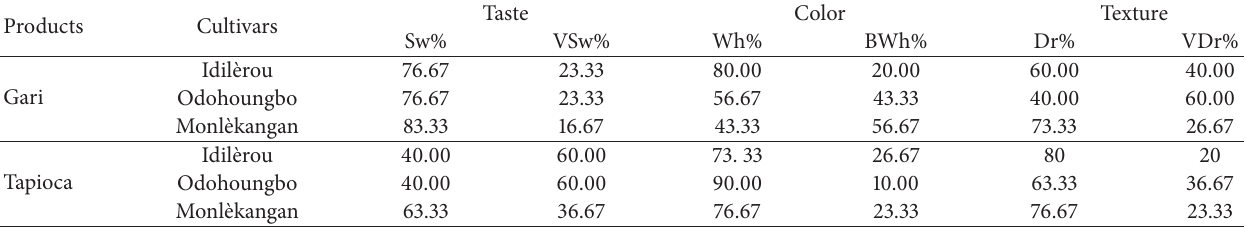
Table 5: Sensory profiles of gari and tapioca from the three most preferred cassava elite cultivars. Products Cultivars